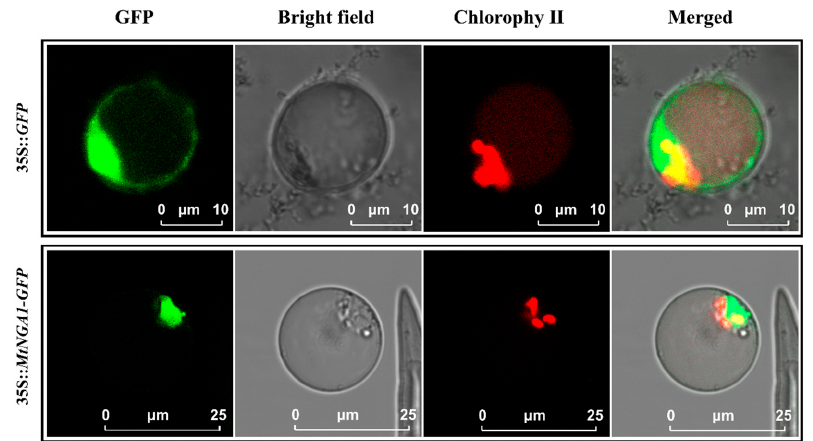
Figure 2. Subcellular localization of the MtNGA1 proteins. Under the green fluorescence excitation channel, MtNGA1-GFP obviously localized to the nucleus (green). 35S:: GFP scale bars = 10 µ m, 35S:: MtNGA1-GFP scale bars = 25 µ m.